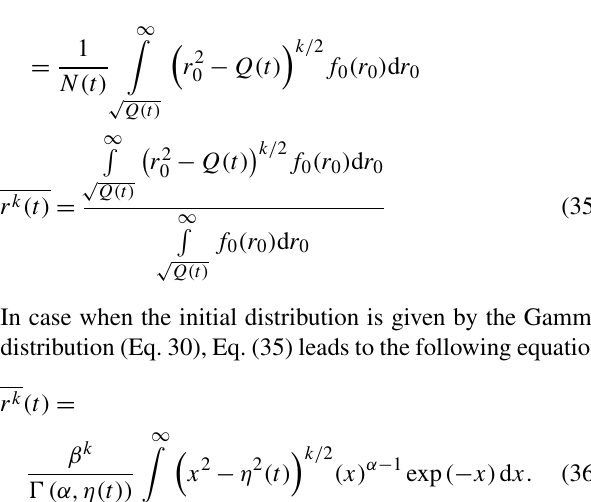
Figure 8. Time dependencies of normalized droplet concentration for an initially narrow DSD (a) and an initially wide DSD (b) at initially different values of RH 0 in the resulting volume. The dependencies are calculated directly using a parcel model (solid lines) and using Eq. (33) (dashed lines). The thermodynamic parameters are the same as in Fig. 7. Parameters of the initial DSDs are given in Table